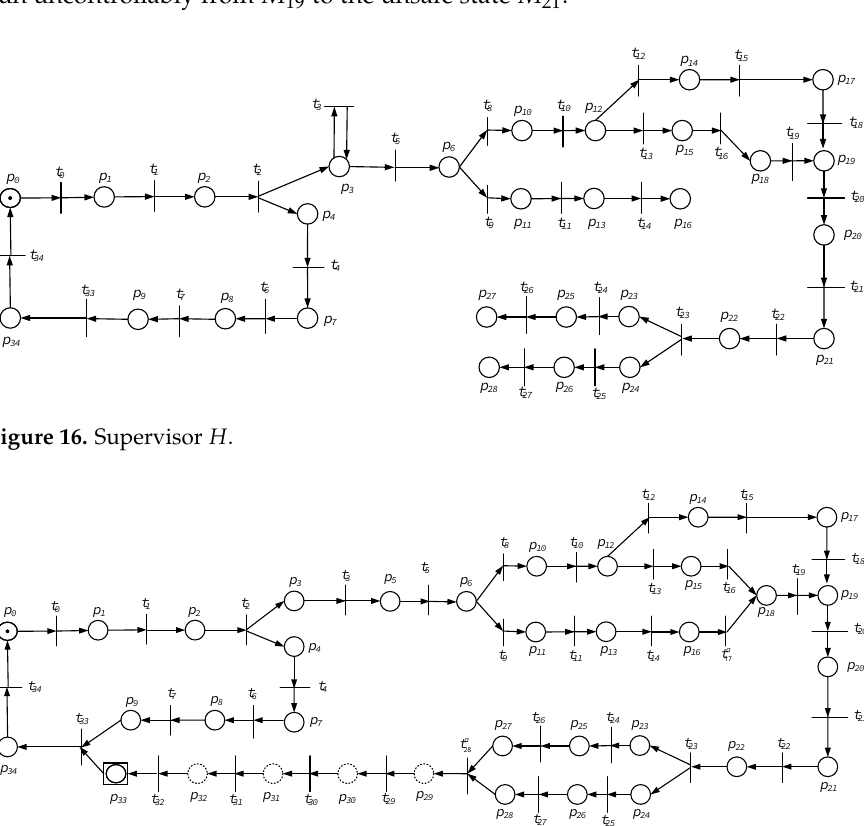
Figure 17. The closed-loop system under attacks G M